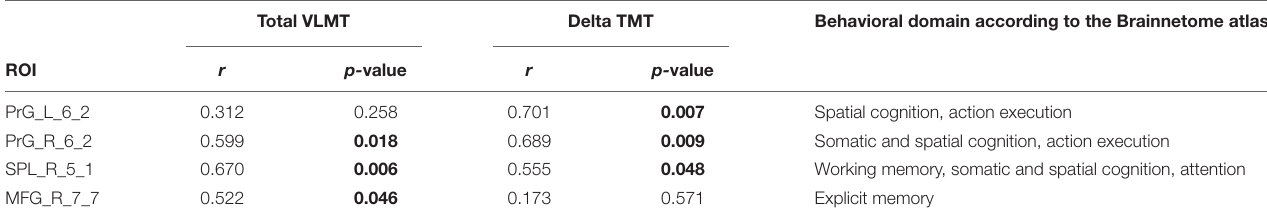
TABLE 3 | Correlation between DC of cognition-related compensatory ROIs, total VLMT, and delta TMT scores in MCI.